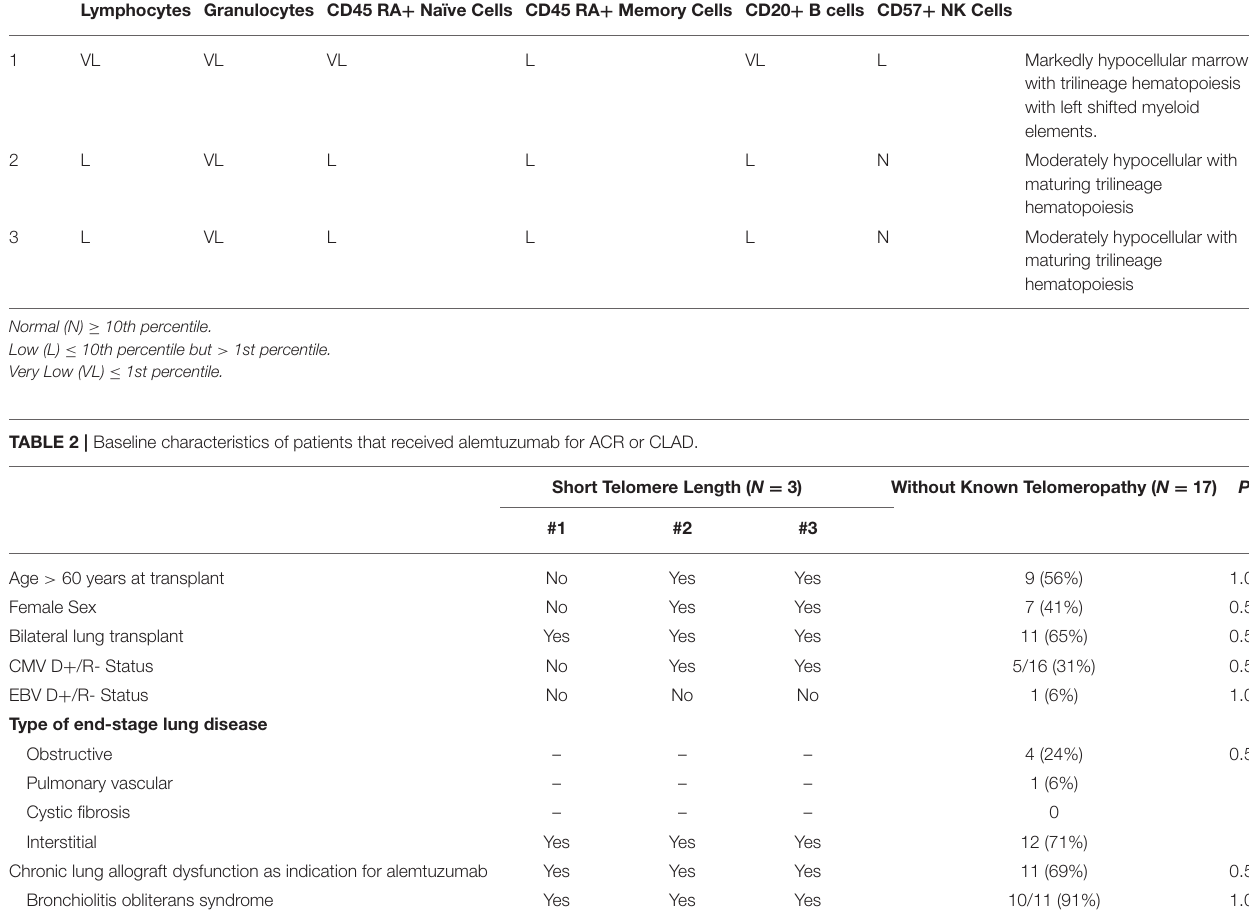
TABLE 1 | Age-adjusted telomere lengths in various cell lines and bone marrow biopsy results in patients with short telomeres. Patient